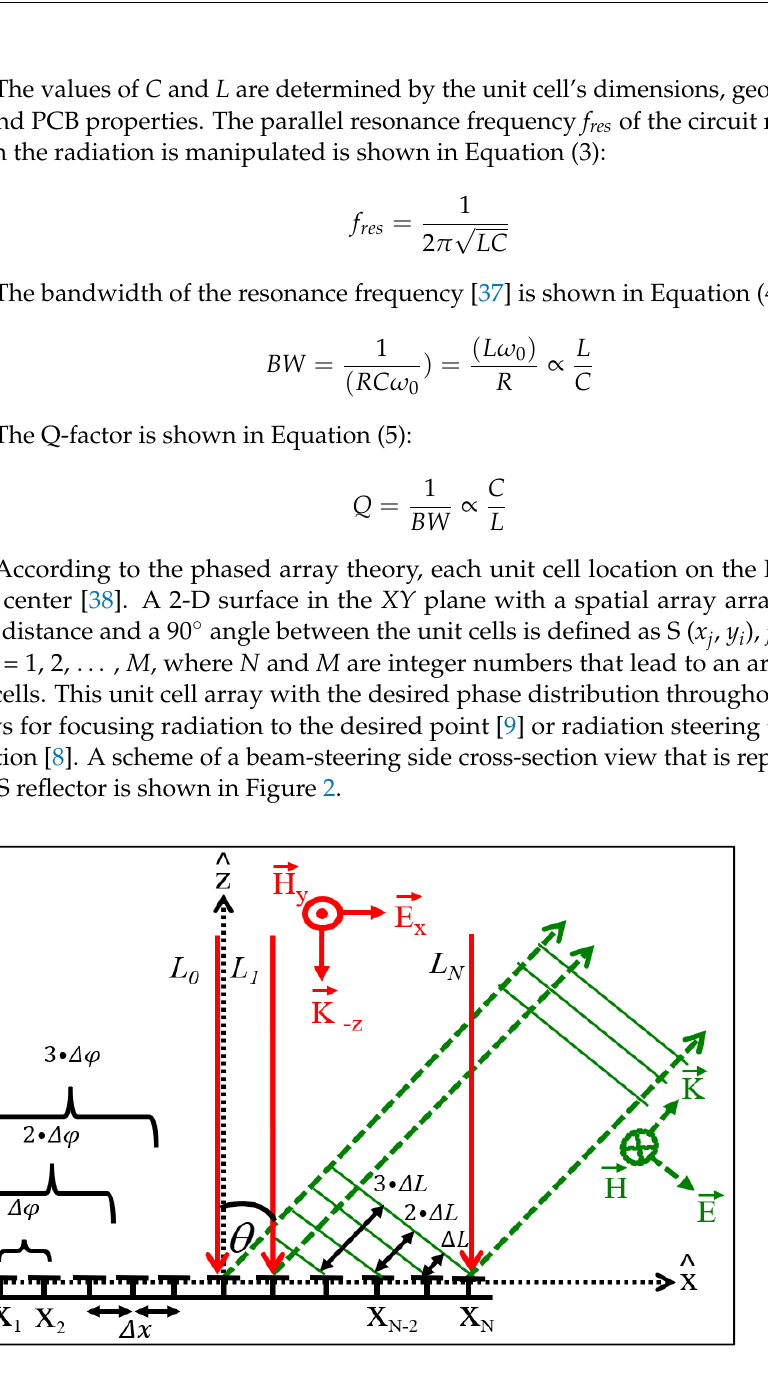
Figure 2. MS reflector side cross ‐ section view scheme of the beam ‐ steering principle.